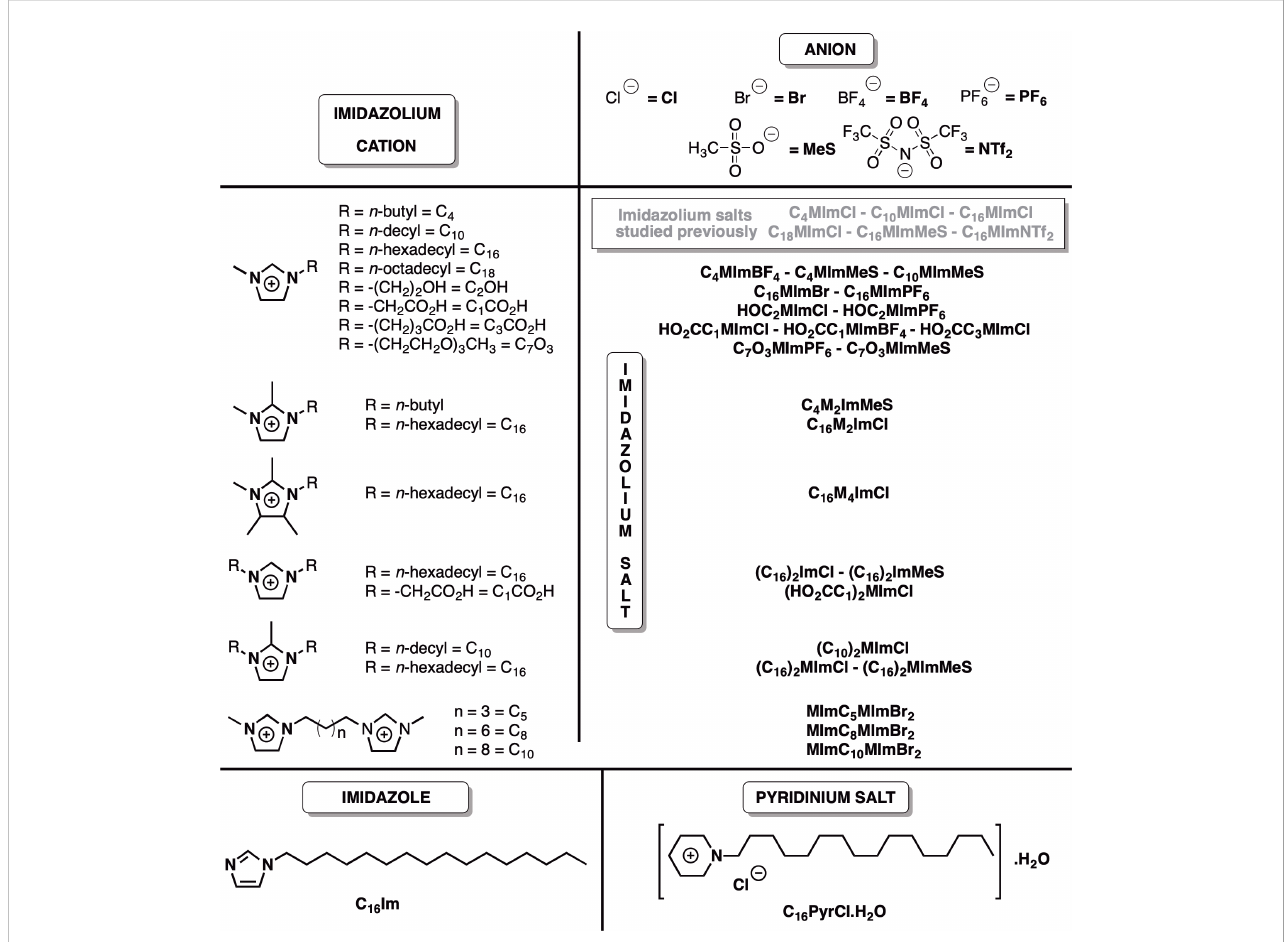
FIGURE 1 Chemical structures of the imidazolium salts, C 16 Im and C 16 PyrCl screened for anti- Leishmania activity tested in this work, and imidazolium salts studied previously for anti- Leishmania activity (ref 13). The compounds were given sample codes that contain information on their chemical structures. For instance, for C 18 MImCl: (1) C 18 = N -octadecyl substituent; (2) M = N -methyl substituent; (3) Im = imidazolium cation; and (4) Cl = chloride